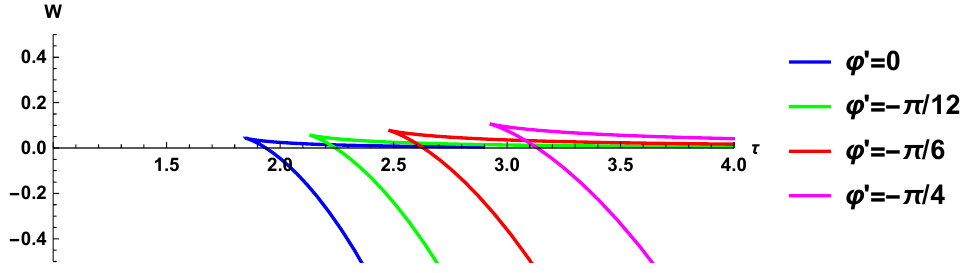
Figure 4 . The BPS free energy W as function of the BPS temperature τ for negative values of ϕ 0 . The two angular momenta are equal ( a = b ) and ϕ 0 = 0 , − π/ 12 , − π/ 6 , − π/ 4 , from left to right. For each value of ϕ 0 , there are two branches that meet in a cusp. The small black hole banch (the upper branch) asymptote to a positive BPS free energy at large temperature for ϕ 0 < 0